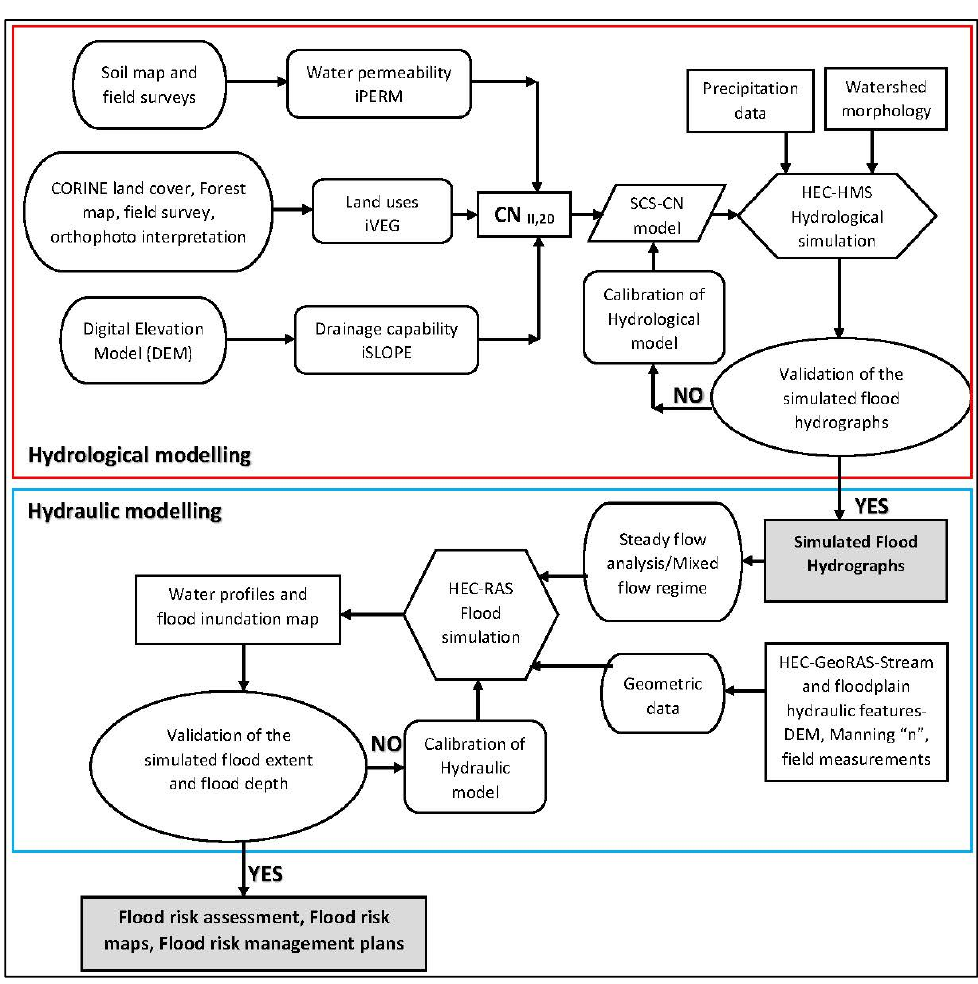
Figure 11. Flowchart of the methodology, data, models, and software that were used. Curve Number, CN; SCS-CN, Soil Conservation Service Curve Number; HEC-HMS, Hydrologic Engineering Center's-Hydrologic Modeling System; HEC-RAS, Hydrologic Engineering Center's-River Analysis System.